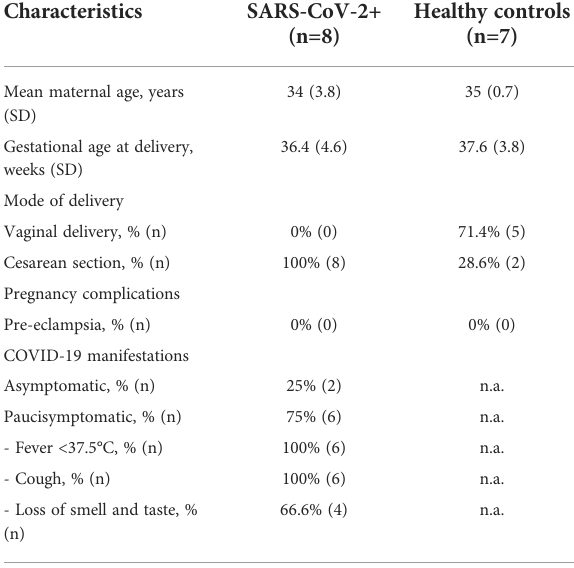
TABLE 1 Clinical characteristics of women enrolled in the